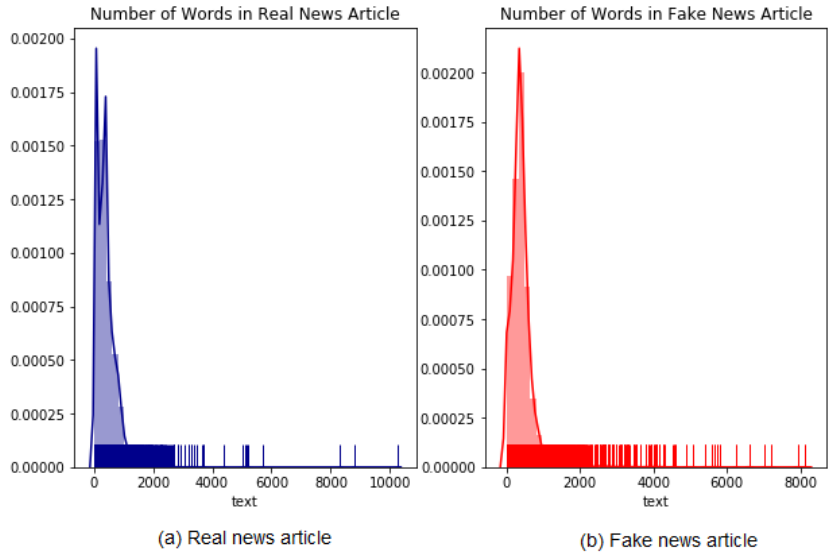
Figure 9. The distribution of Real and Fake news body